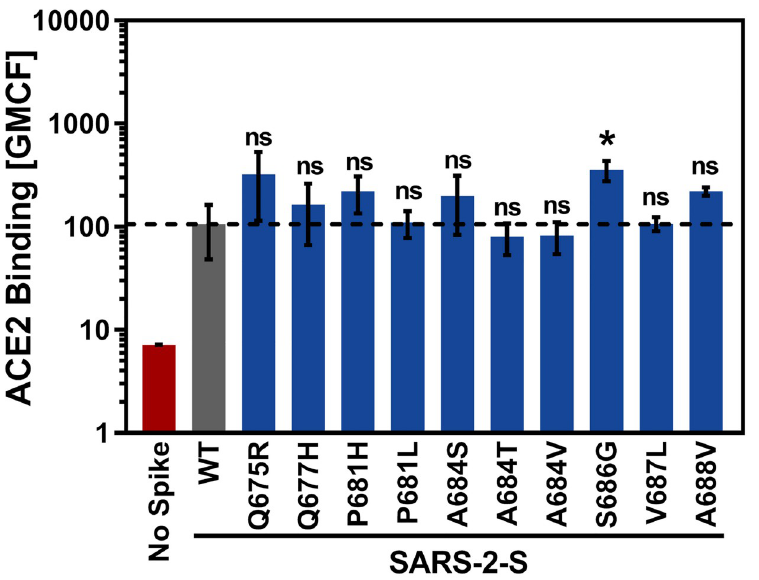
Fig 2. Mutations at the S1/S2 site have little impact on soluble ACE2-Fc binding. 293T cells expressing the indicated S protein mutants were incubated with soluble ACE2-Fc and binding was detected using an Alexa488-coupled secondary antibody and flow cytometry. Cells that did not express S protein were used as negative control. The average geometric mean channel fluorescence (GMCF) of three independent experiments is shown. Error bars represent the standard deviation (SD). Statistical significance was analysed by two-tailed Student’s t-test with Welch’s correction (p > 0.05, not significant [ns], p � 0.05, � ). WT = wildtype.